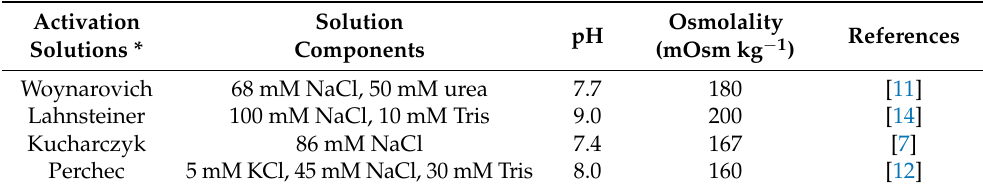
Table 1. Activation solutions with different ionic compositions, pH values, and osmolality used for ide ( Leuciscus idus, n = 5) sperm motility activation. * Each solution contained 0.5% bovine serum albumin